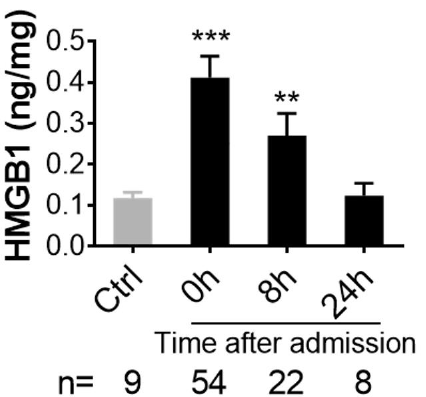
Figure 1. HMGB1 is significantly elevated after injury in trauma patients. Blood plasma from 54 casualties (on admission 8 and 24 h after admission to a hospital) and 9 civilian volunteers (Control, “ Healthy ” ) was used for analysis. High mobility group box protein 1 (HMGB1), an inflammatory factor, was measured by ELISA. The data are expressed as nanograms per milligram total plasma proteins and presented as mean ± SEM, ** = p < 0.01, *** = p < 0.001 vs. Control (Ctrl). Table 1. Blast wave parameters. Legend: B + H group = blast + hemorrhage; CX-01 group = blast + CX-01; P0 (peak pressure) in kPa (the kilopascal, a unit of pressure); t+ (he positive-pressure phase duration in milliseconds (ms)); I (impulse (kPa-ms)). Reference Overpressure Reflected P0 (kPa) t+ (ms) I (kPa-ms) P0 (kPa) t+ (ms) I (kPa-ms) P0 (kPa) t+ (ms) I (kPa-ms) B+H (n = 9) 109.38 ± 1.27 3.31 ± 0.01 140.26 ± 0.86 117.26 ± 1.36 3.29 ± 0.01 141.38 ± 0.87 161.40 ± 2.07 3.48 ± 0.03 178.46 ± 1.35